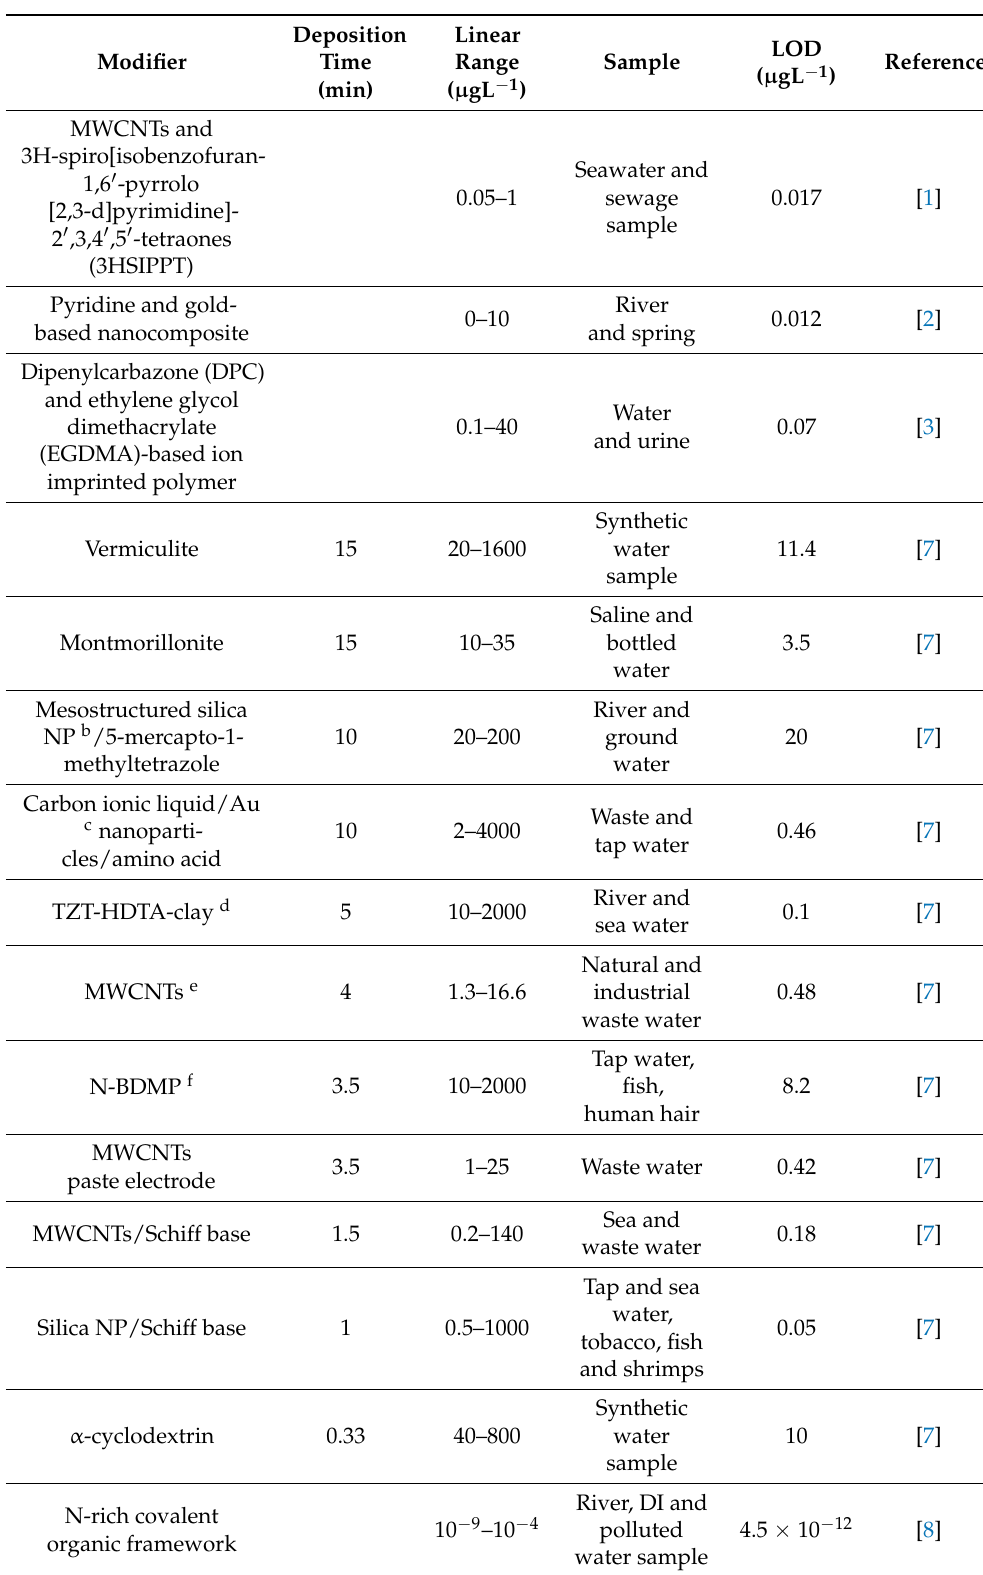
Table 2. Comparison of current voltammetric method with other modified carbon paste electrodes applied for stripping analysis of